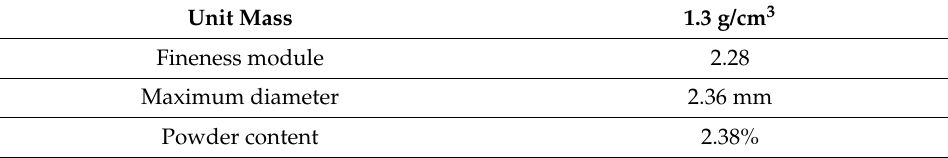
Table 3. Fine aggregate